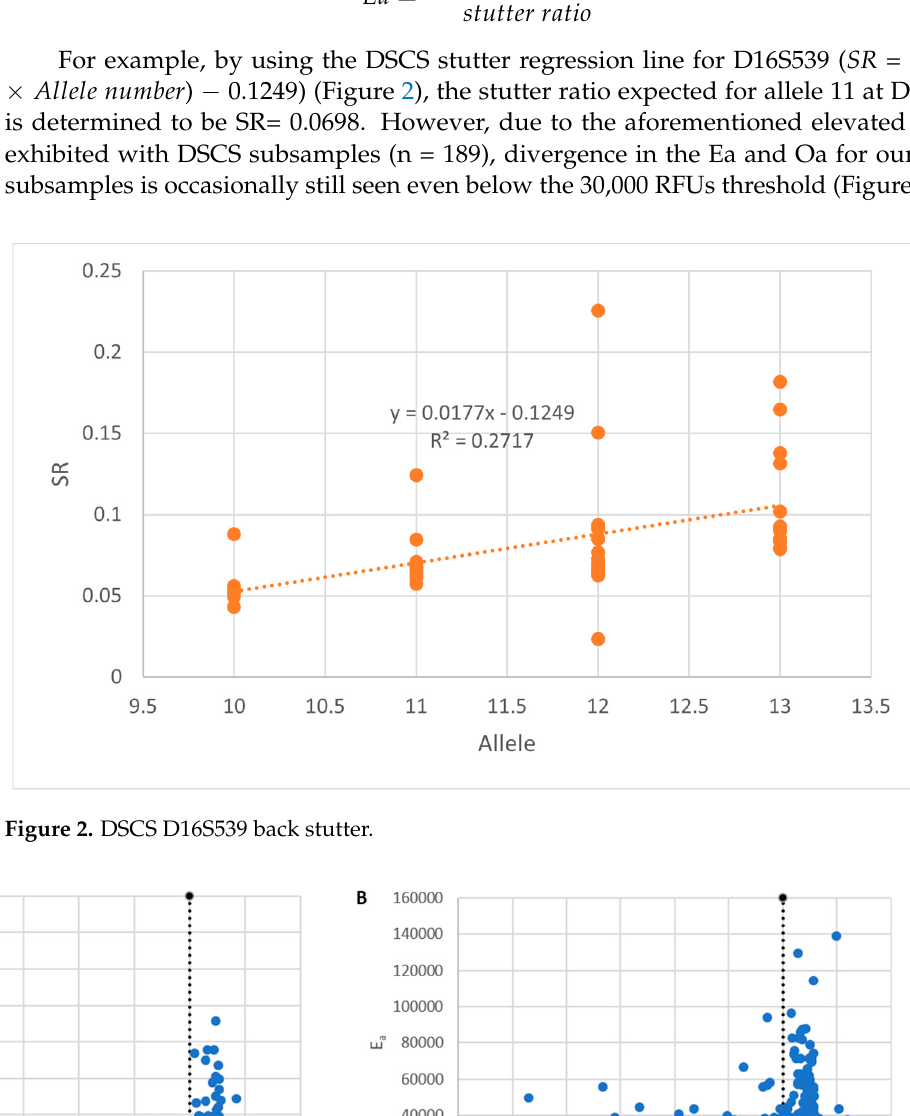
Figure 2. DSCS D16S539 back stutter.